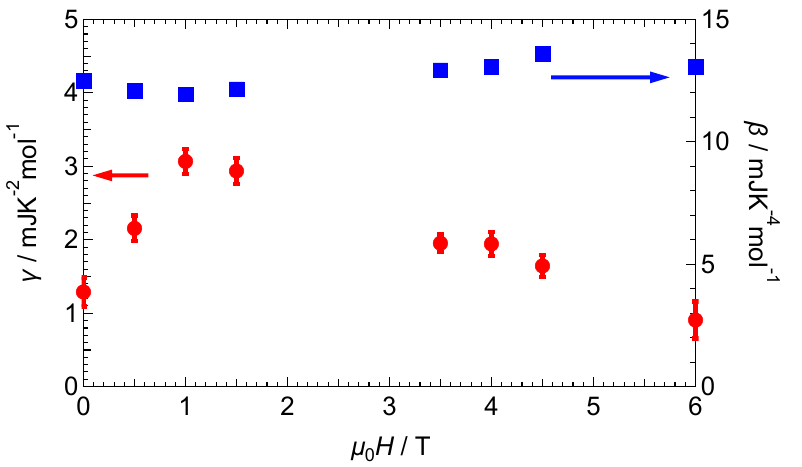
Figure 5. Magnetic fields dependence of the thermodynamic parameters γ and β of the d[3,3] compound. The peak structure at 1.0 T means that the normal state electronic heat capacity coefficient of this compound was about 3.0 mJ K −2 mol −1 . The decrease of γ above this field means that an insulating component was induced in the high-field region. The translucent curves are guides for the eye.